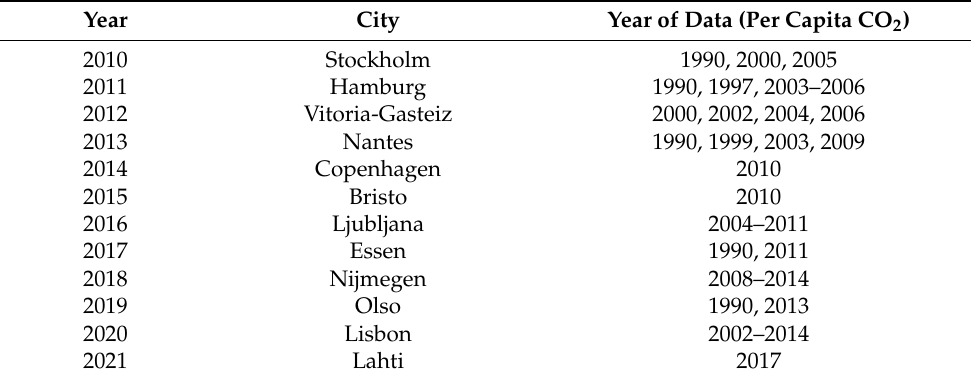
Table 2. List and data of the European Green Capital Award (EGCA)-winning